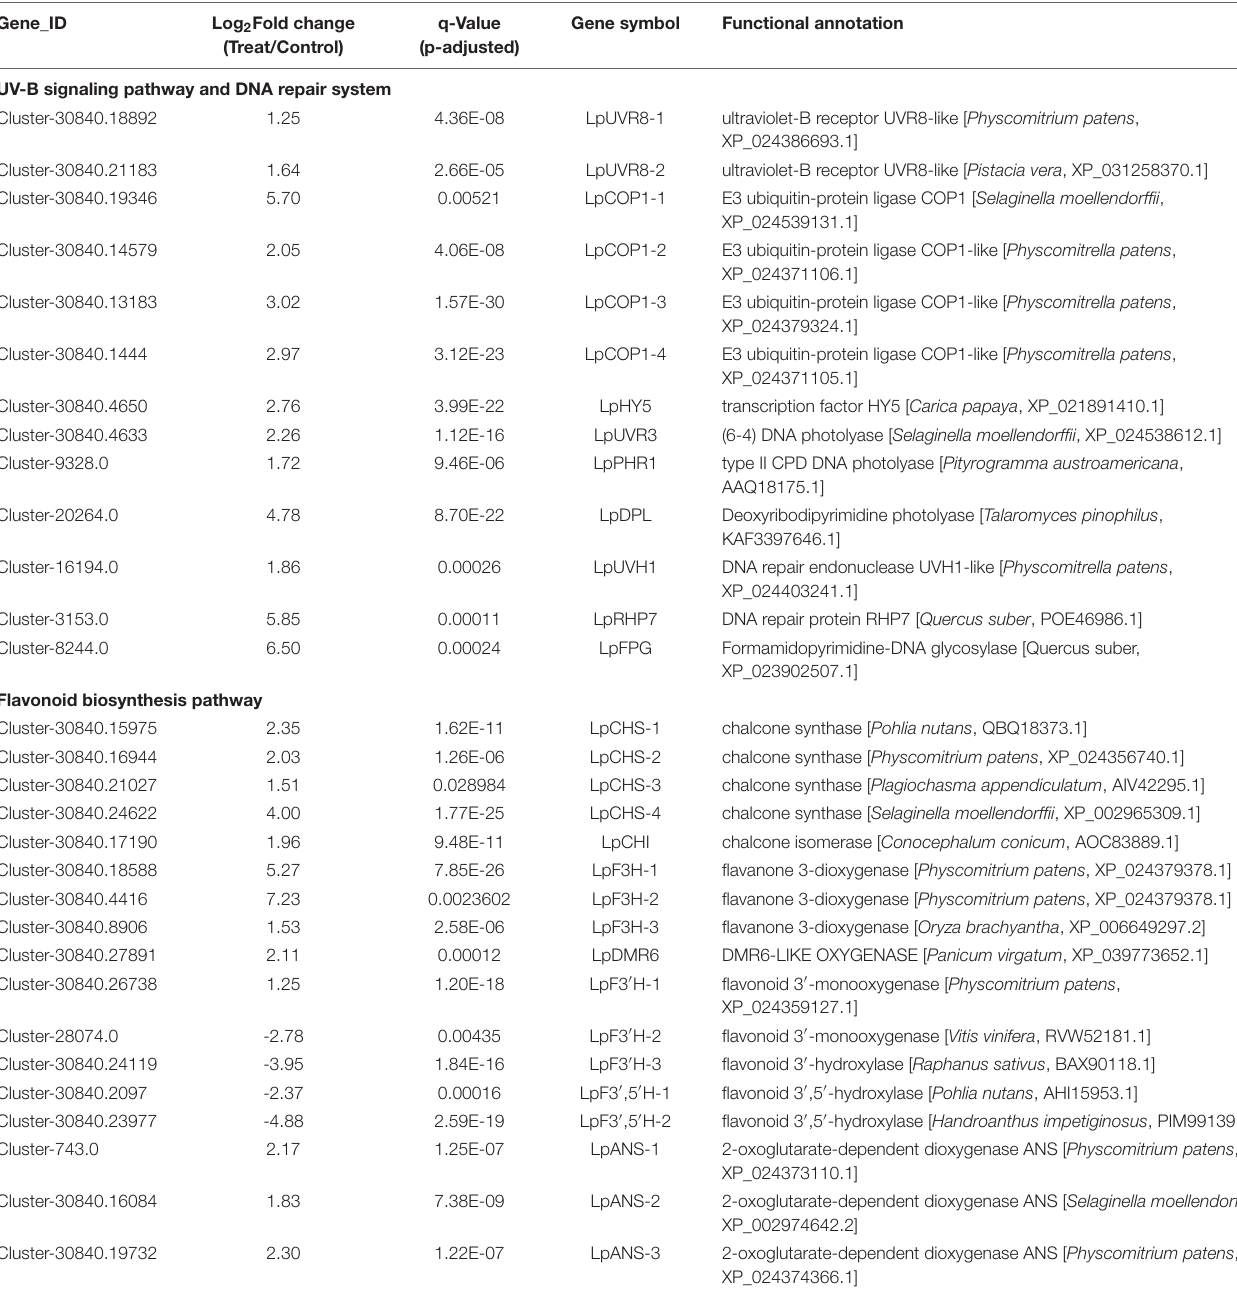
TABLE 2 | Representative UV-B stress-related genes of the Antarctic moss L. pyriforme. Gene_ID Log 2 Fold change q-Value Gene (Treat/Control) (p-adjusted)